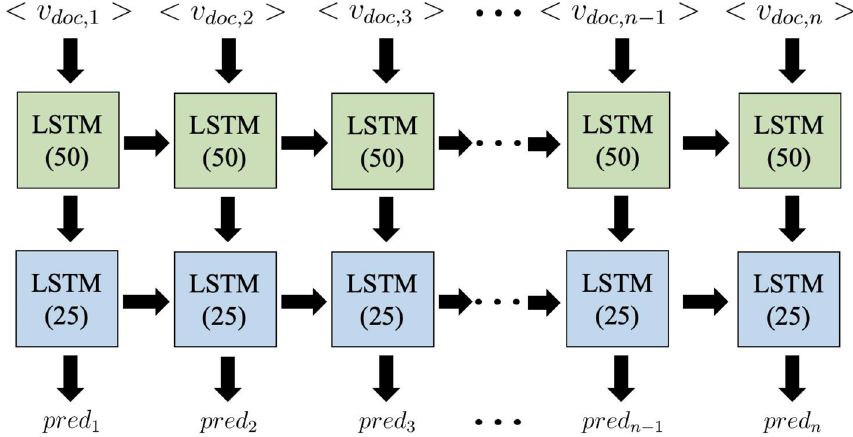
Figure 8. LSTM model architecture for breast cancer recurrence